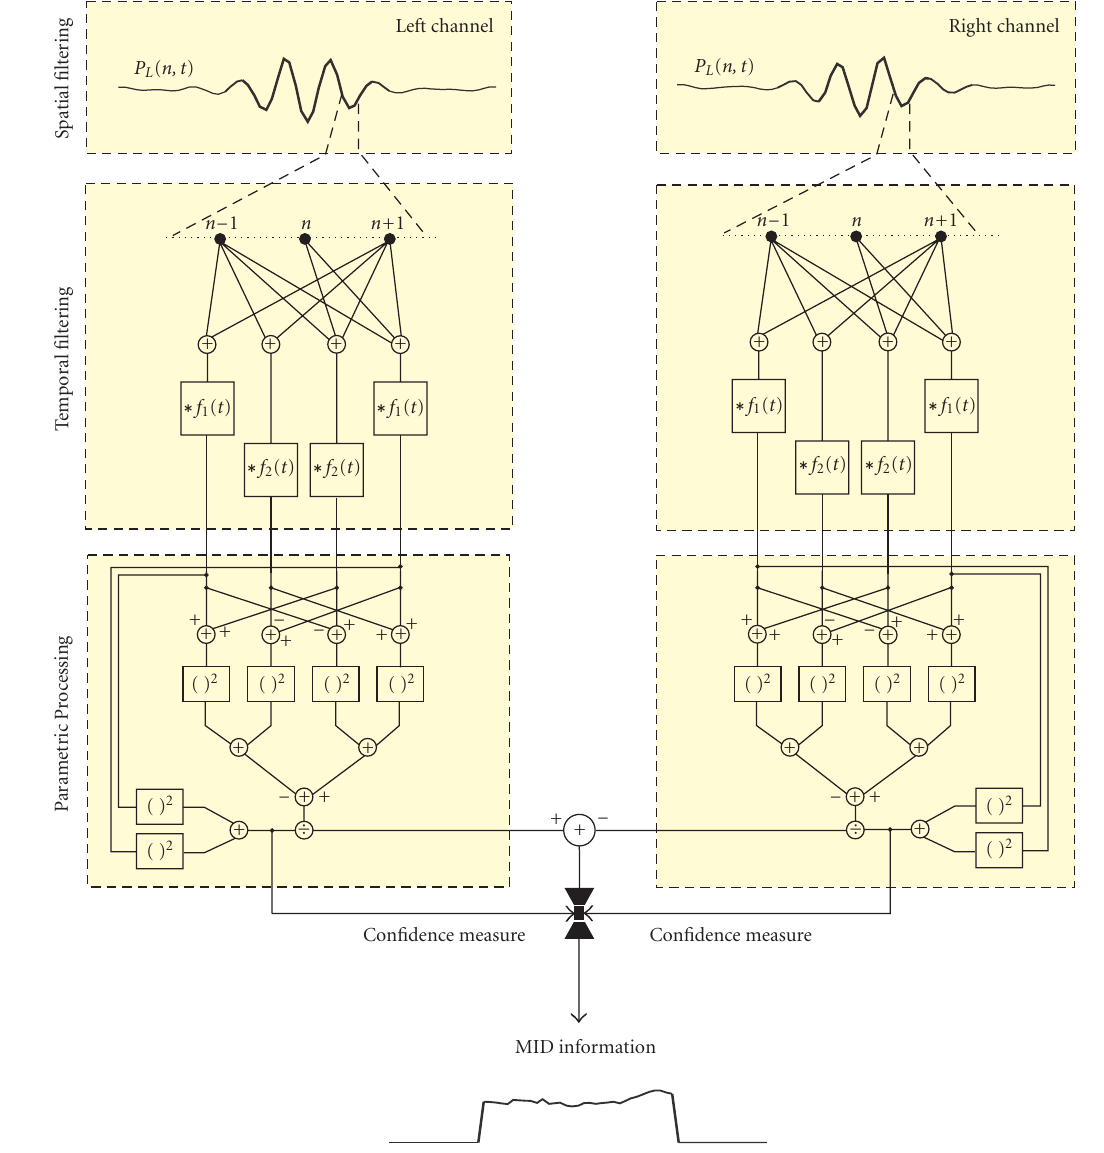
Figure 3: Architectural scheme of the neuromorphic MID